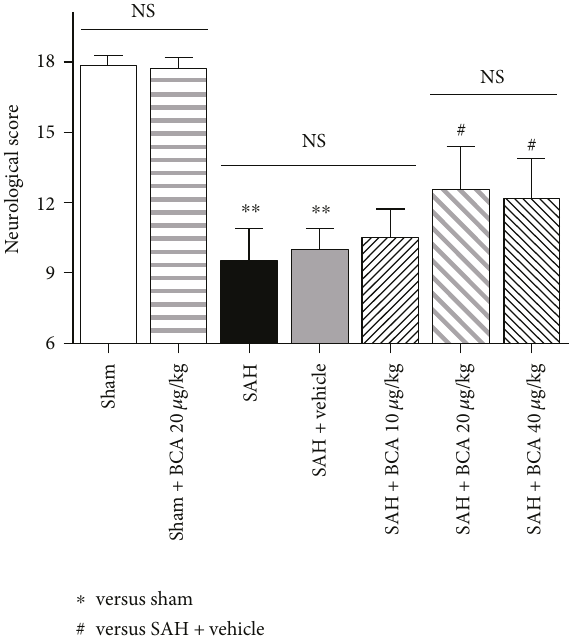
Figure 2: The e ff ects of BCA on neurological function at 24-hour post-SAH rats and sham rats. ( n = 6 , each group; ∗∗ P < 0 01 versus sham; # P < 0 05 versus SAH+ vehicle; NS P > 0 05 ).